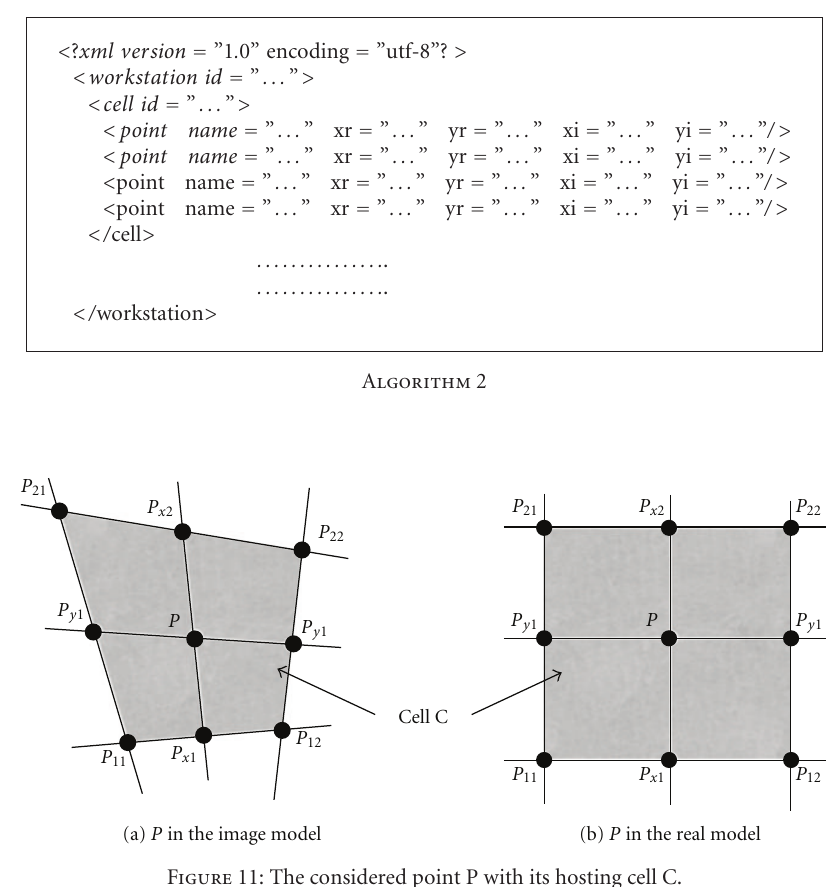
Figure 11: The considered point P with its hosting cell